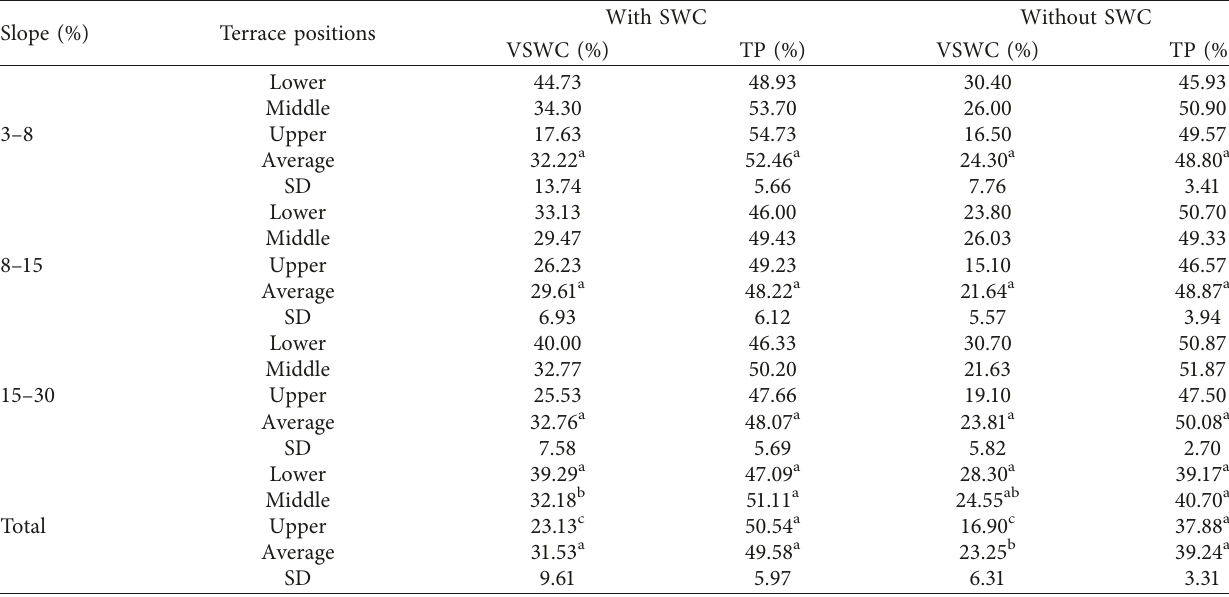
Table 4: Mean values of volumetric soil water content (VSWC) and total porosity (TP) in 0 to 20cm depth in the Geshy subcatchment. With SWC Without SWC Slope (%) Terrace positions VSWC (%) TP (%) VSWC (%)